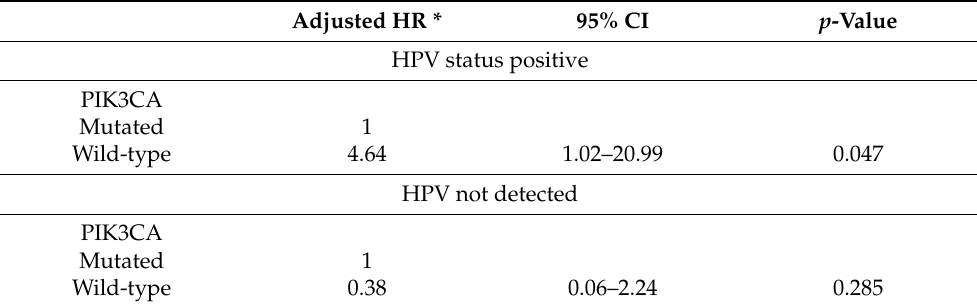
Table 6. Multivariable analysis of PIK3CA mutation associated with disease-free survival, Cox regression model adjusted for p16 overexpression, alcohol/tobacco consumption habits, and age at